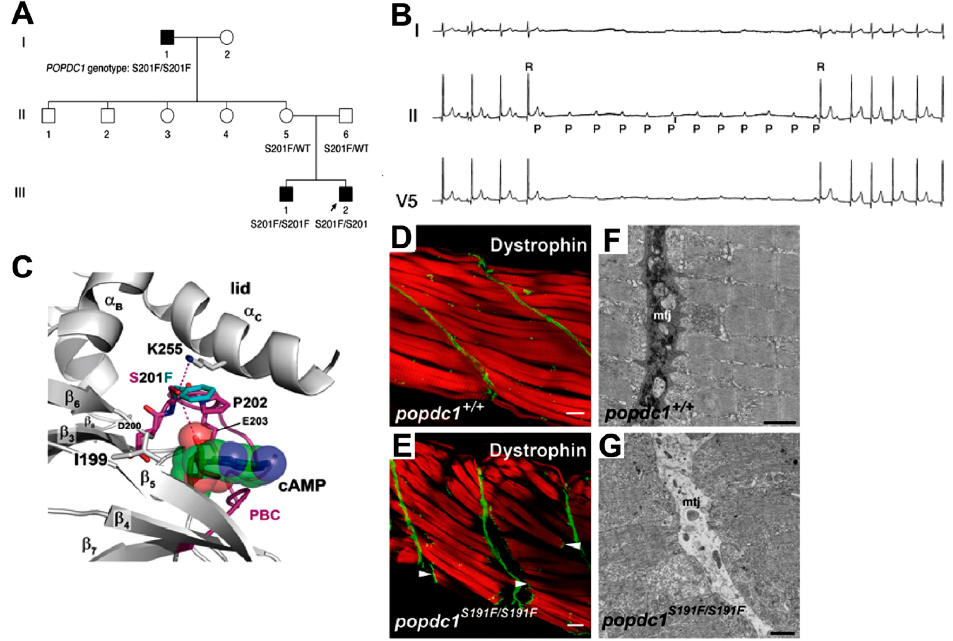
Figure 3. The POPDC1 S201F missense mutation causes cardiac arrhythmia and muscular